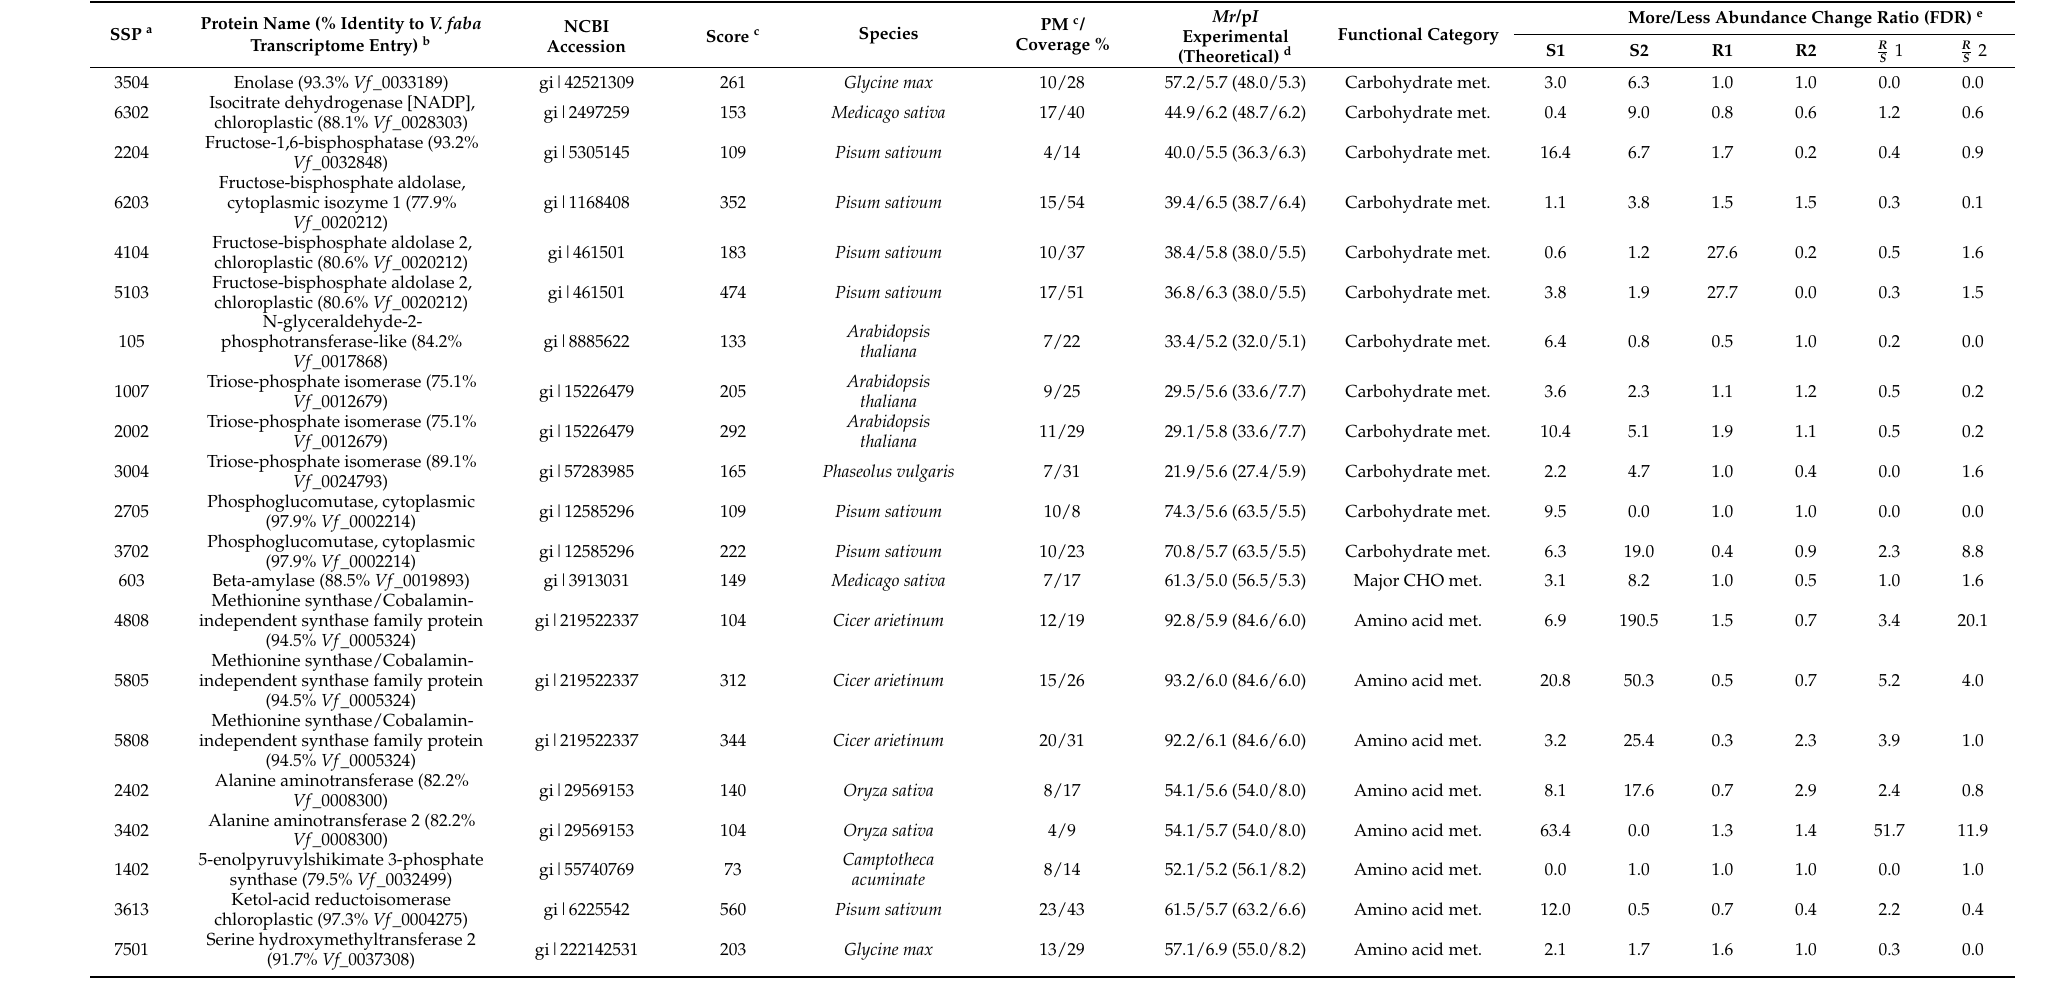
Table 1. Proteins identified by MALDI-TOF MS